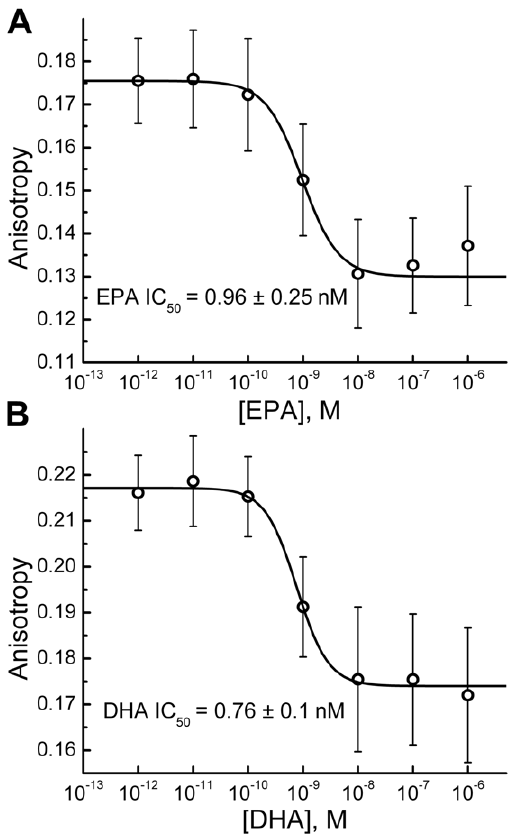
Figure 6. Fluorescence anisotropy of PTH1R membranes labeled with nM PTH(1–34) TMR as function of EPA or DHA concentration. Displacement binding of 2 nM PTH(1–34) TMR with (A) EPA and (B) DHA after 4 hours incubation time. Data represents the mean of at least 15 independent experiments.